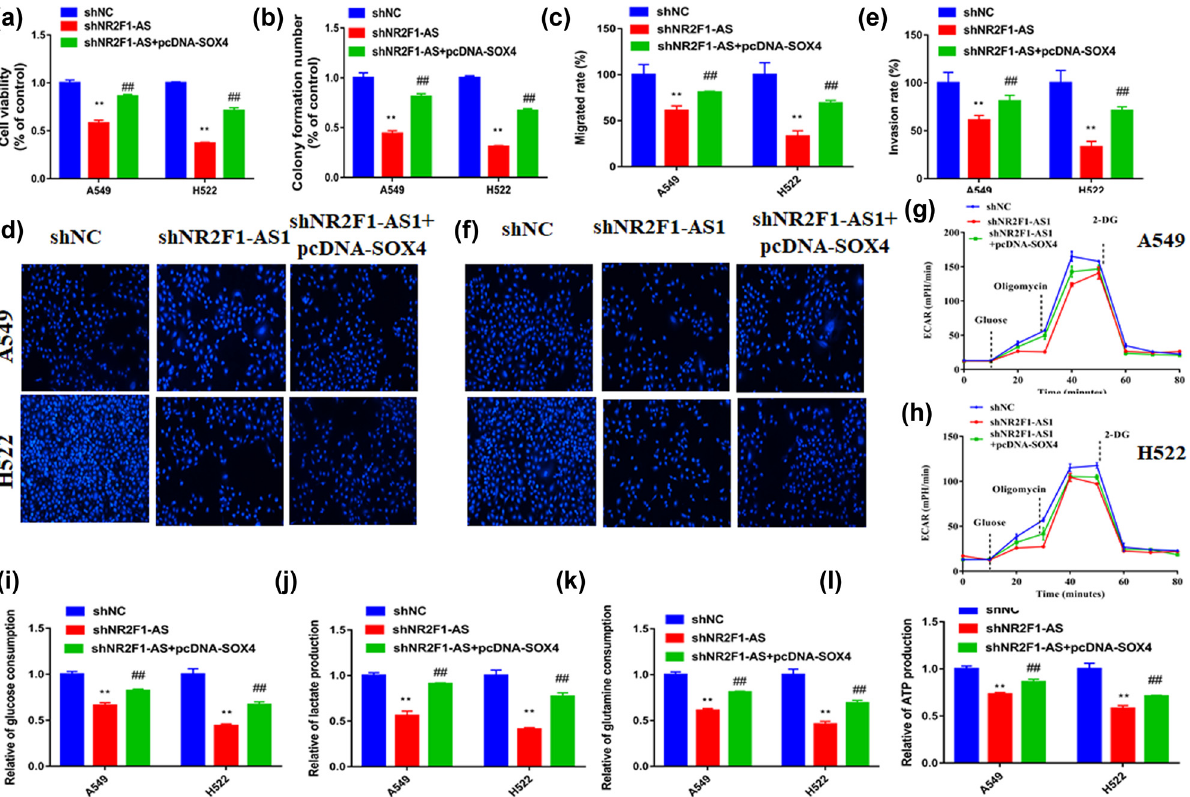
Figure 7: NR2F1 - AS1 promoted NSCLC progression by SOX4 overexpression. A549 and H522 cells were transfected with sh - NC, sh - NR2F1 - AS1, and sh - NR2F1 - AS1 + pcDNA - SOX4. ( a ) The viability, ( b ) colony number, ( c and d ) migration, and ( e and f ) invasion of cells were determined using CCK8 assay, colony formation assay, and transwell assay. ( g and h ) Cell glycolysis, ( i ) glucose consumption, ( j ) lactate production, ( k ) glutamine consumption, and ( l ) ATP production were evaluated by the corresponding assay, respectively. ** P < 0.01 compared with the sh - NC group. ## P < 0.01 compared with sh - NR2F1 - AS1